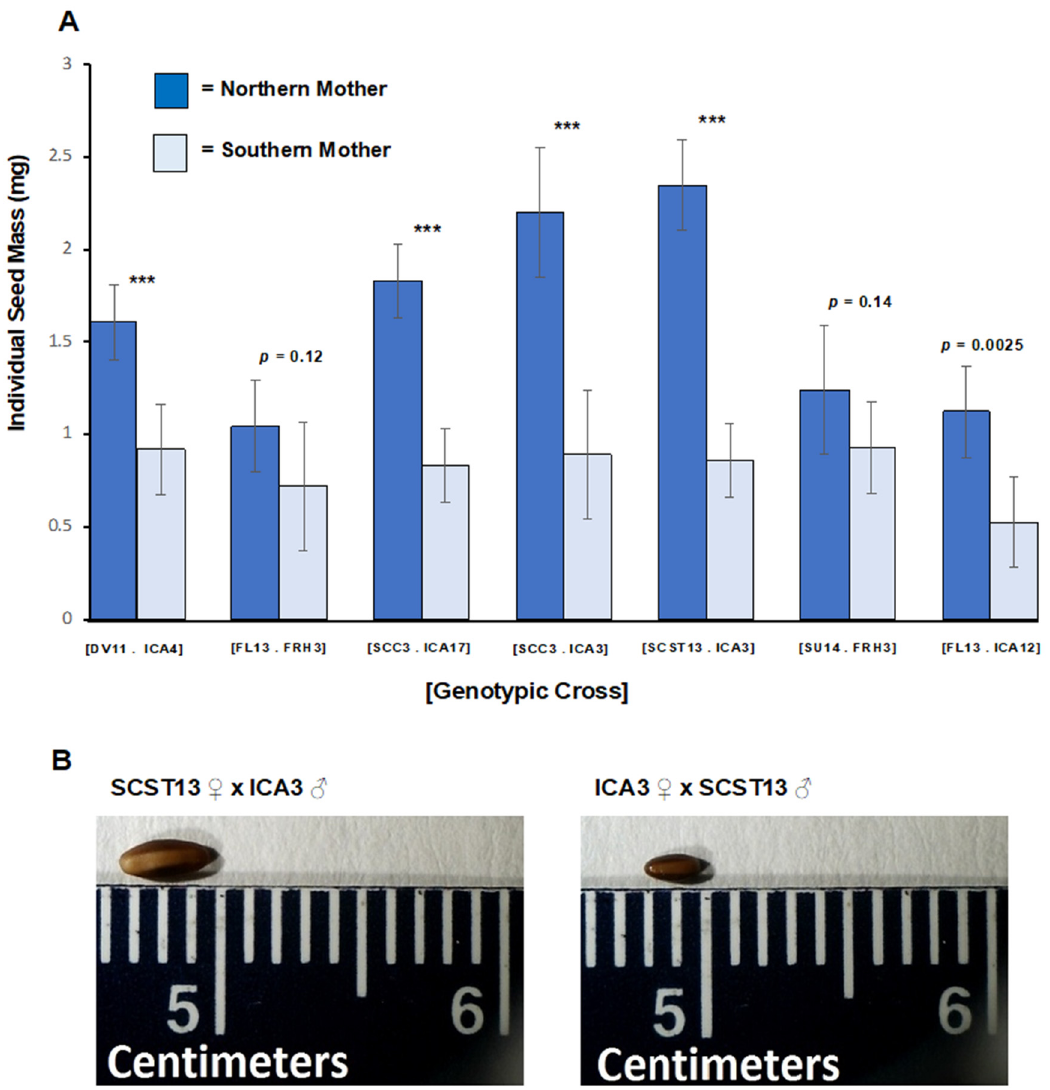
Figure 2. Experiment 1: ( A ) Mean individual seed mass ± 95% CI shown by reciprocal cross and maternal parent for each of seven reciprocal genotypic crosses. Genotypic crosses are identified by brackets. Each parental genotype is identified by grandparental wild population and maternal ID. Northern populations: Veno, Denmark (DV). Lund, Finland (FL), Cupar, Scotland (SCC), St. Andrews, Scotland (SCST), and Upsala, Sweden (SU); Southern populations: Hameau de St. Felix, France (FRH), Castel Volturno, and Italy (ICA). Dark blue = northern mother/southern father; Light blue = southern mother/northern father. *** = p < 0.0001. ( B ) Representative seeds produced by a northern mother (SCST 13) and by a southern mother (ICA 3) for a genotypic cross.